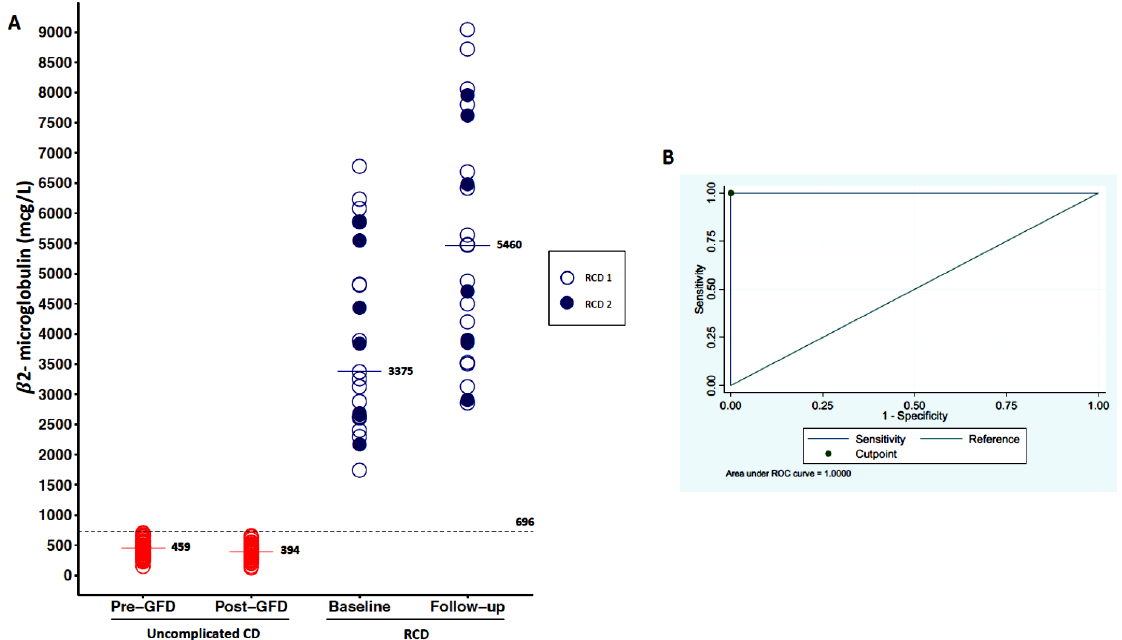
Figure 2. Variation of β 2-microglubine levels. ( A ) shows the variability of β 2-microglubine levels in the three groups of patients (uncomplicated CD, RCD type 1, RCD type 2) at baseline and at follow-up. Serum levels of β 2-microglubine at baseline were higher in patients with RCD in comparison to uncomplicated CD before a GFD. ( B ) is an ROC curve that show an empirical cut-off point of β 2-microglubine (696 mcg/L), which is able to differentiate uncomplicated CD vs. RCD patients with a sensitivity of 100% and a specificity of 100%.